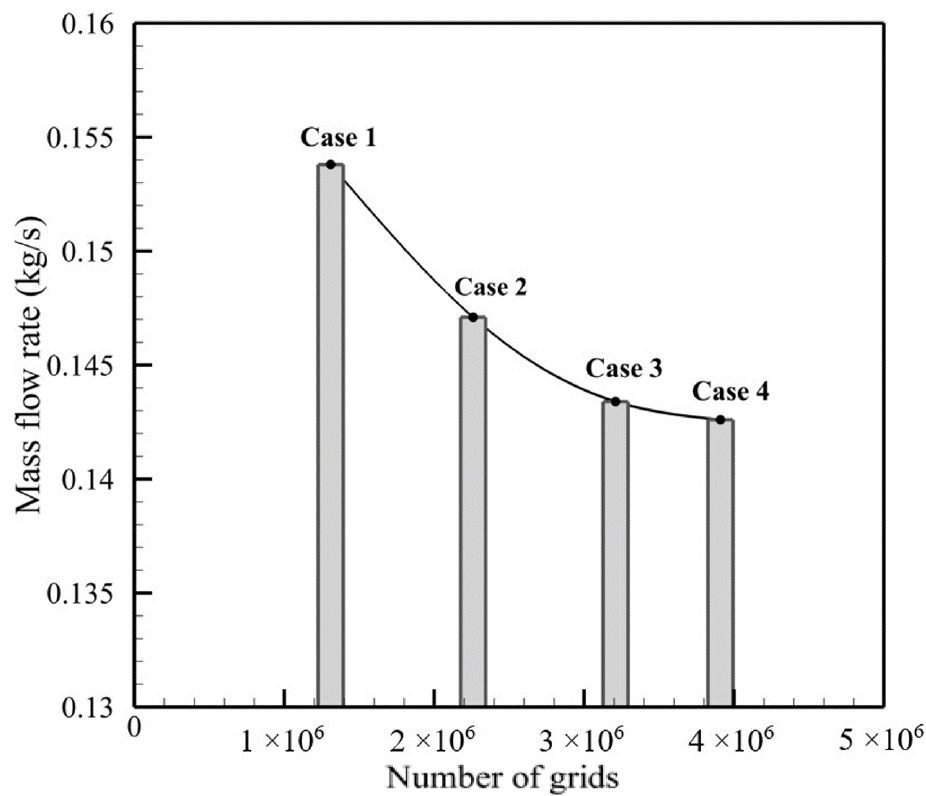
Figure 9. Grid independency of the current study according to the inlet wind velocity of 1.5 m/s.